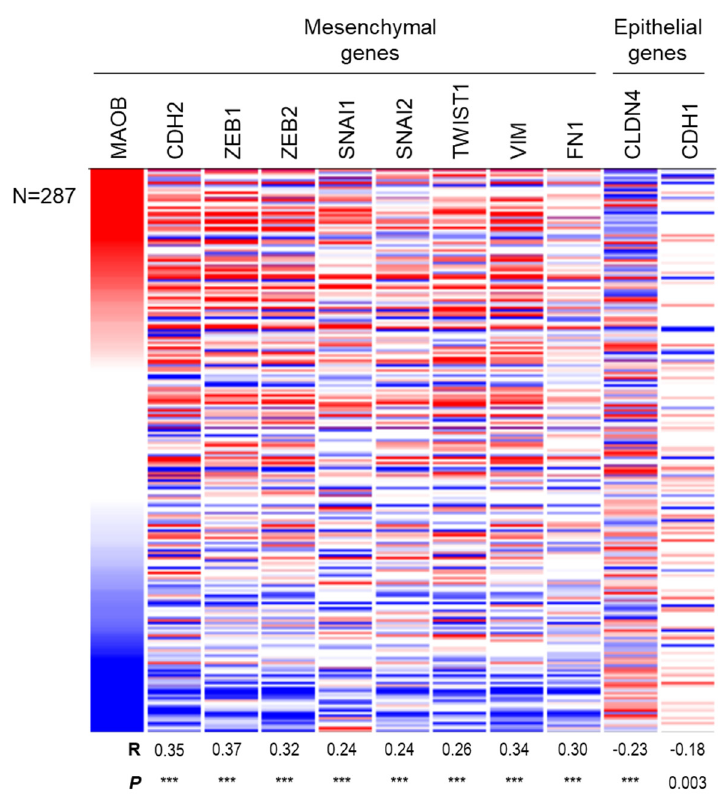
Figure 5. The correlation of MAOB expression with epithelial-to-mesenchymal transition (EMT)-related genes in colorectal cancer patients. Visualization of expressions of MAOB and EMT-related genes in 287 colon cancer patients from The Cancer Genome Atlas (TCGA) cohort. Positive correlations between MAOB and mesenchymal markers and negative correlations between MAOB and epithelial markers. R indicates the Pearson’s R value, and *** indicates p < 0.0001.